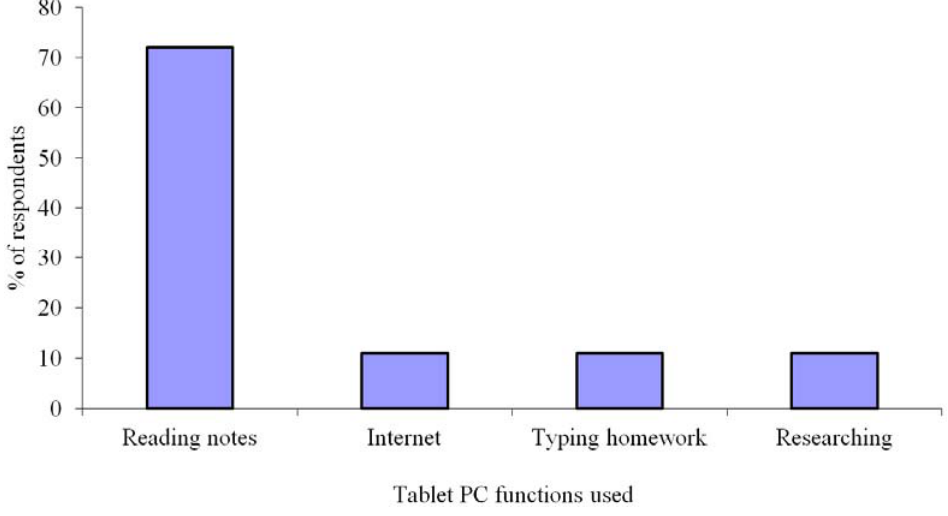
Fig. 3. Tablet PC applications